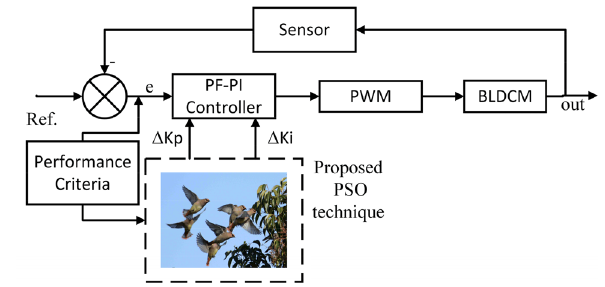
Fig. 3 Setup FLC of a e , ec MFs and domains, and b Kp , and c Ki MFs and domains